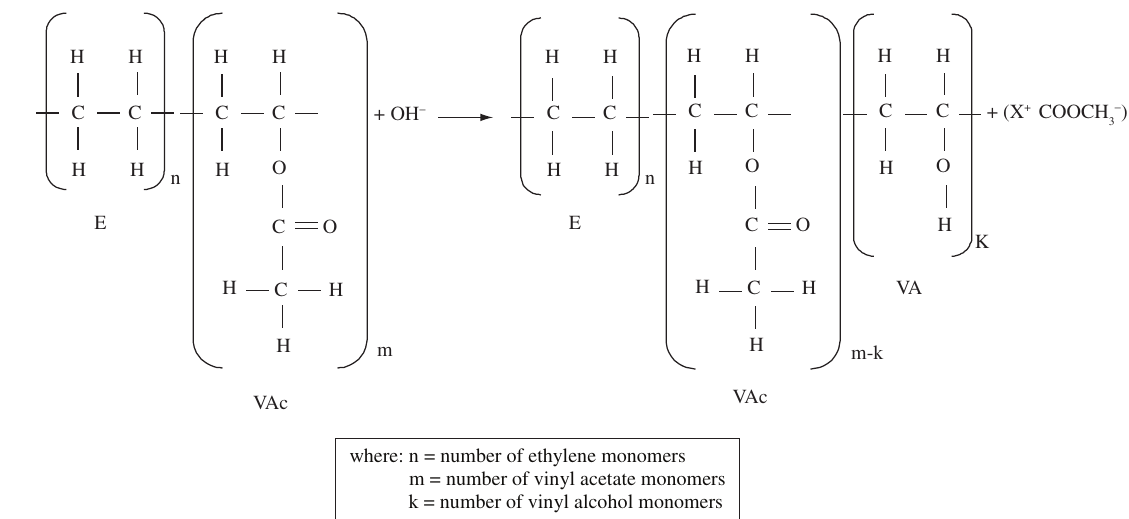
Figure 10. Hydrolysis reaction from vinyl acetate units (VAc) to vinyl alcohol (VA) in EVA copolymer chain under alkaline